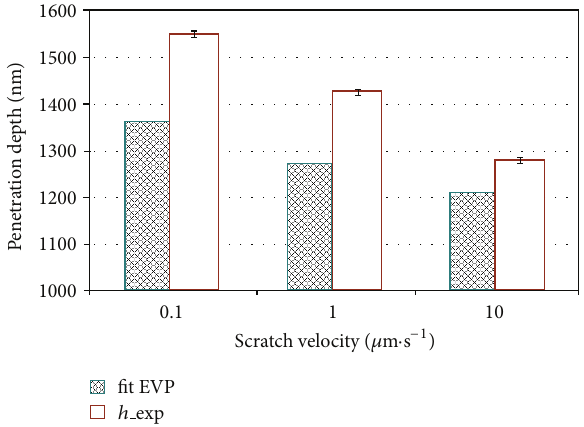
Figure 10: Comparison of experimental results ( ℎ exp) and numer- ical results (fit EVP) for 𝐹 𝑛 = 40 mN. The numerical results have been obtained with the elastic-viscoplastic model in using a Young modulus of 3.75 GPa. The set of parameters have been identified from experimental scratch results at 20mN.